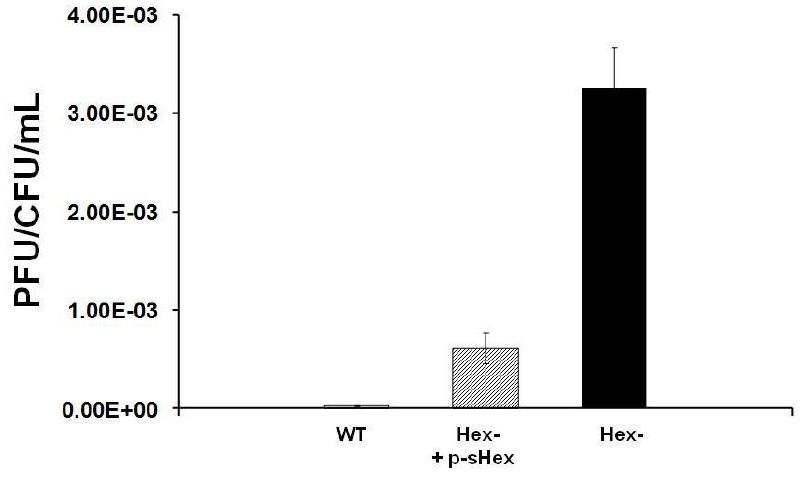
Figure 6. Effect of sHex expression on the stability of MG1655::λ imm434 hex− lysogens